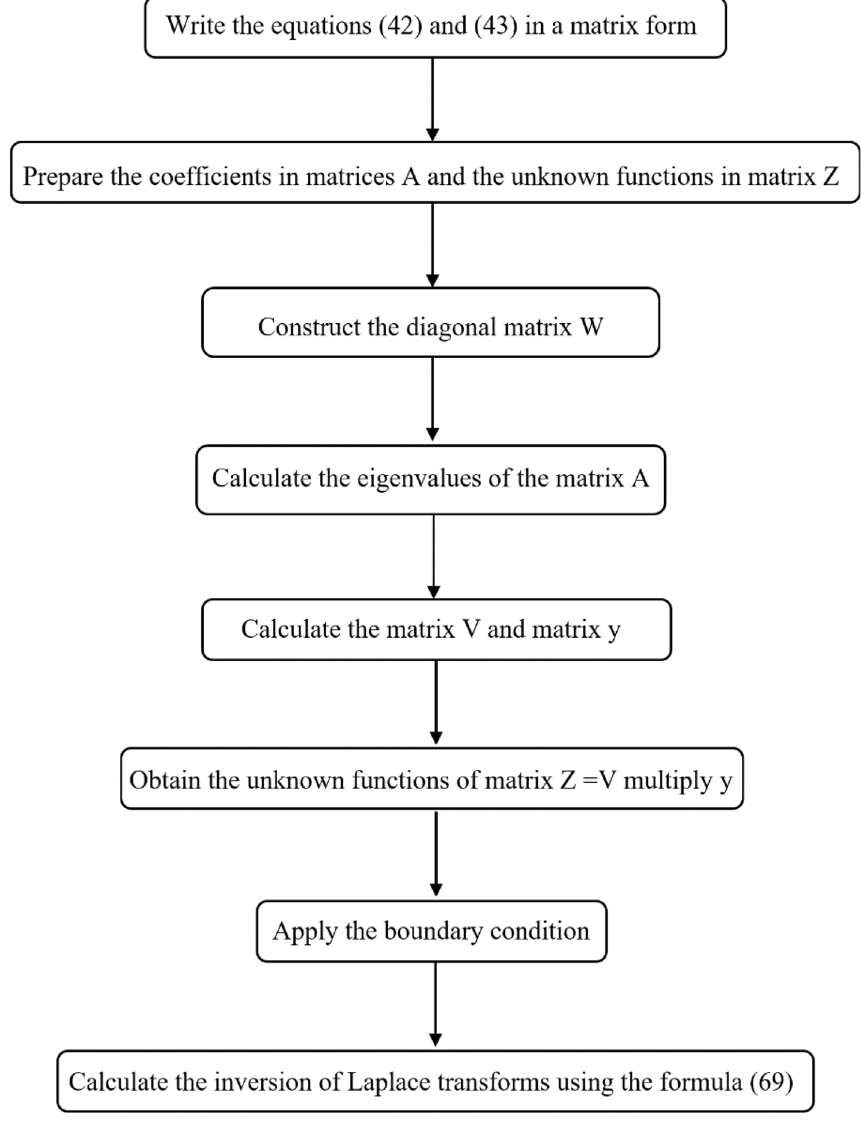
Figure 2. The flowchart of the